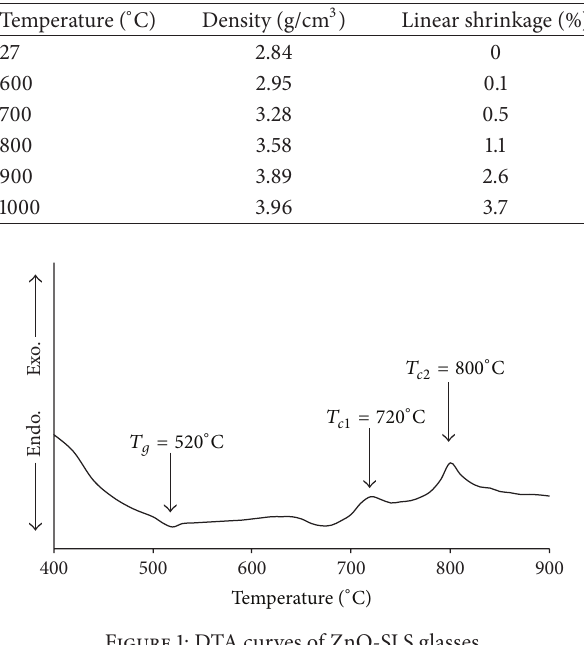
Figure 1: DTA curves of ZnO-SLS glasses.